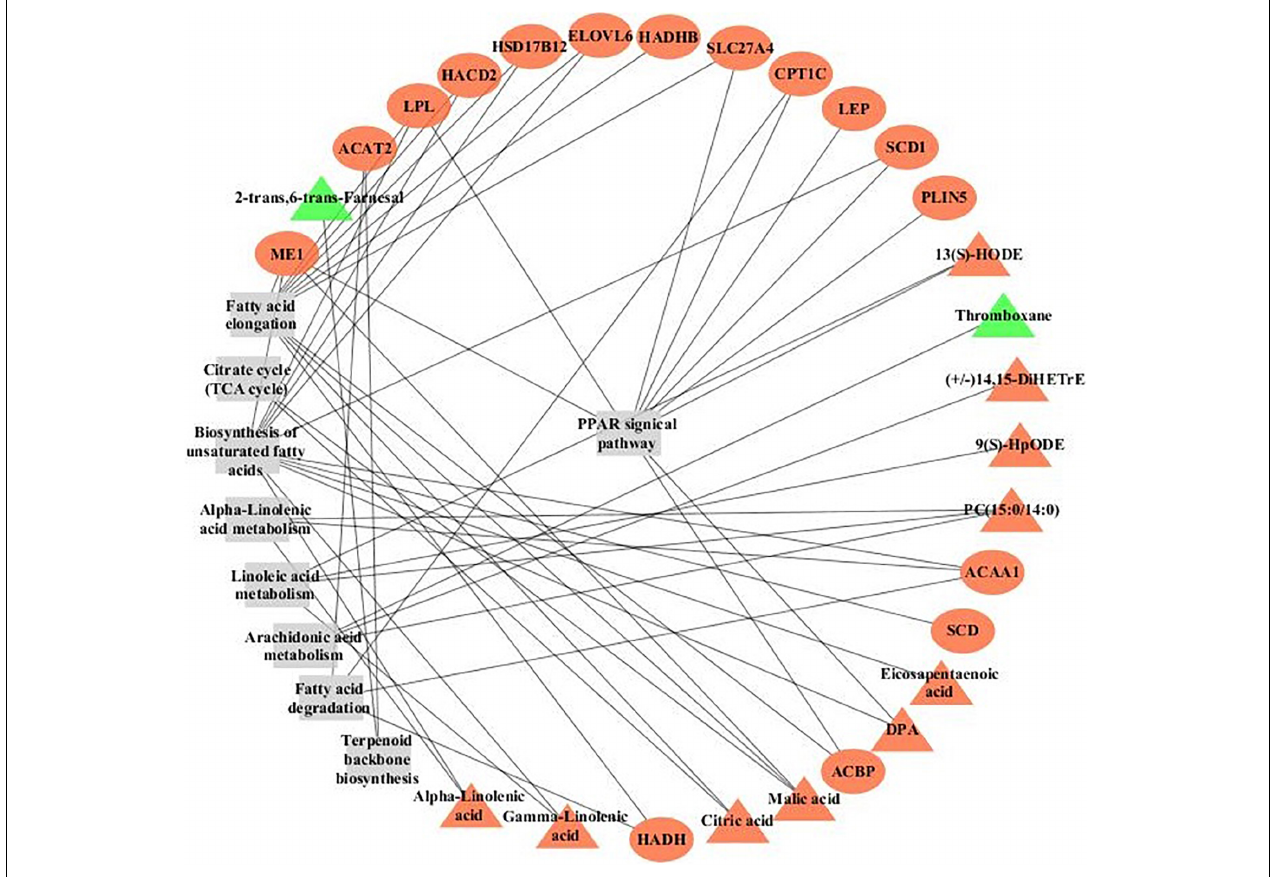
FIGURE 4 | The regulatory networks of DEGs and DMs based on KEGG Markup Language (KGML) in subcutaneous fat of FYs and MYs. Triangles represent metabolites, circles represent genes, and rectangles represent pathway names. Red denotes the upregulated gene or metabolite, and green denotes the downregulated gene or